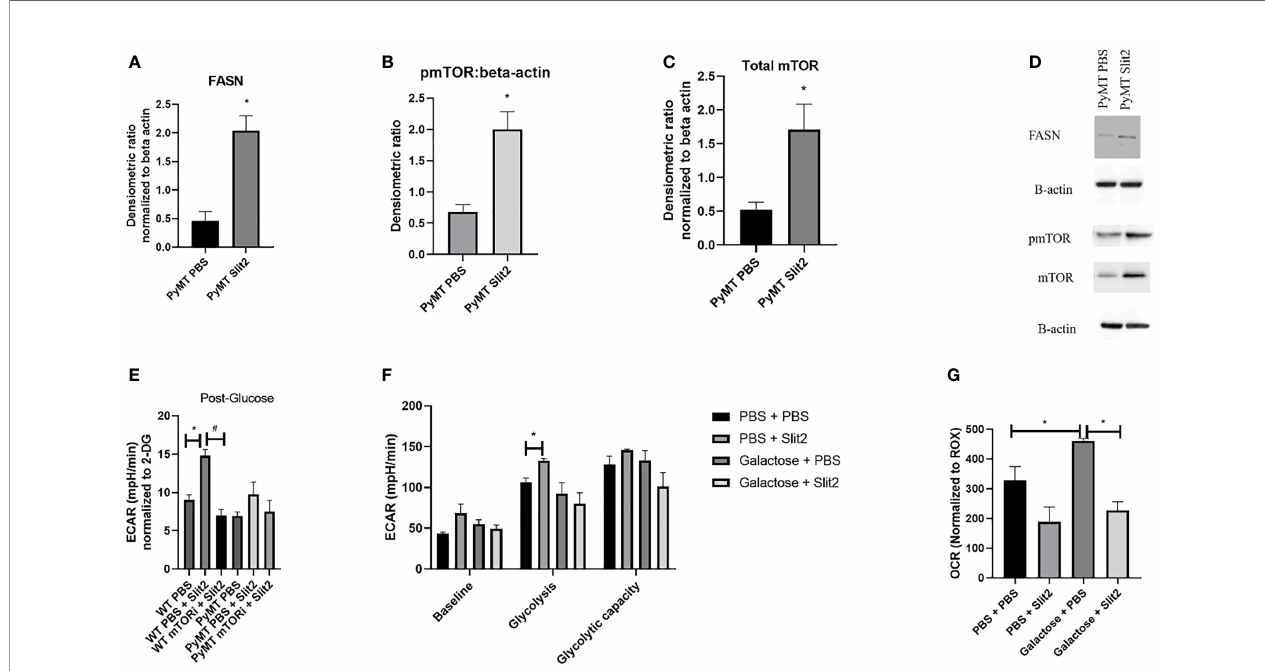
FIGURE 3 | (A) Densitometric ratio of FASN. (B) Densitometric ratio of phosphorylated mTOR to beta-actin. (C) Densiometric ration of total mTOR to beta-actin. (D) Representative blots of Western blot analysis. (E) ECAR in response to glucose in BMDMs from WT and PyMT pretreated with mTOR inhibitor deforolimus (mTORi) and later treated with PBS or Slit2. (F) Glyco Stress test performed in BMDMs treated with Slit2 in the presence or absence of glycolysis inhibitor, galactose. (G) Baseline oxygen consumption rate in BMDMs treated with Slit2 in the presence or absence of glycolysis inhibitor, galactose. Images represent n = 3 – 6/group. *p < 0.05, assessed by unpaired t-test, # p < 0.05 in mTORi and PBS pretreated